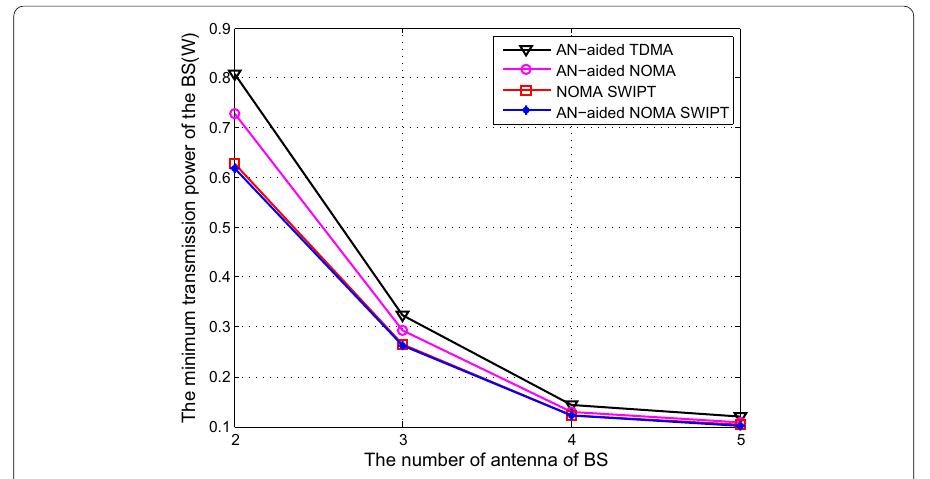
Fig. 7 The minimum transmission power of the BS versus the number of BS’s antennas